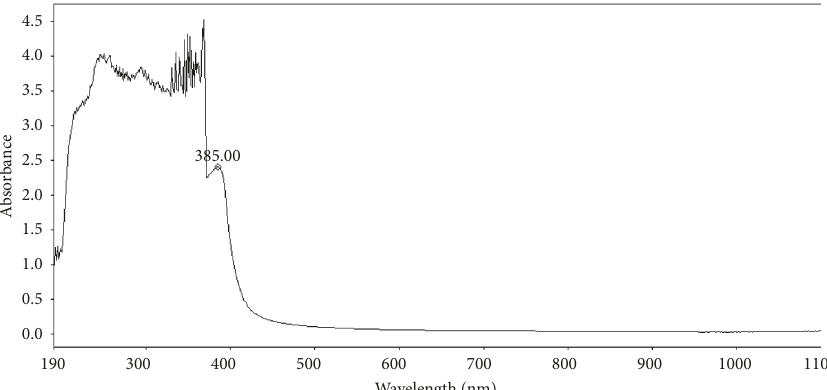
Figure 2: Specific wavelengths of CuO NPs using propolis (Khalkhal) extract in UV-Vis spectrophotometry assessment.